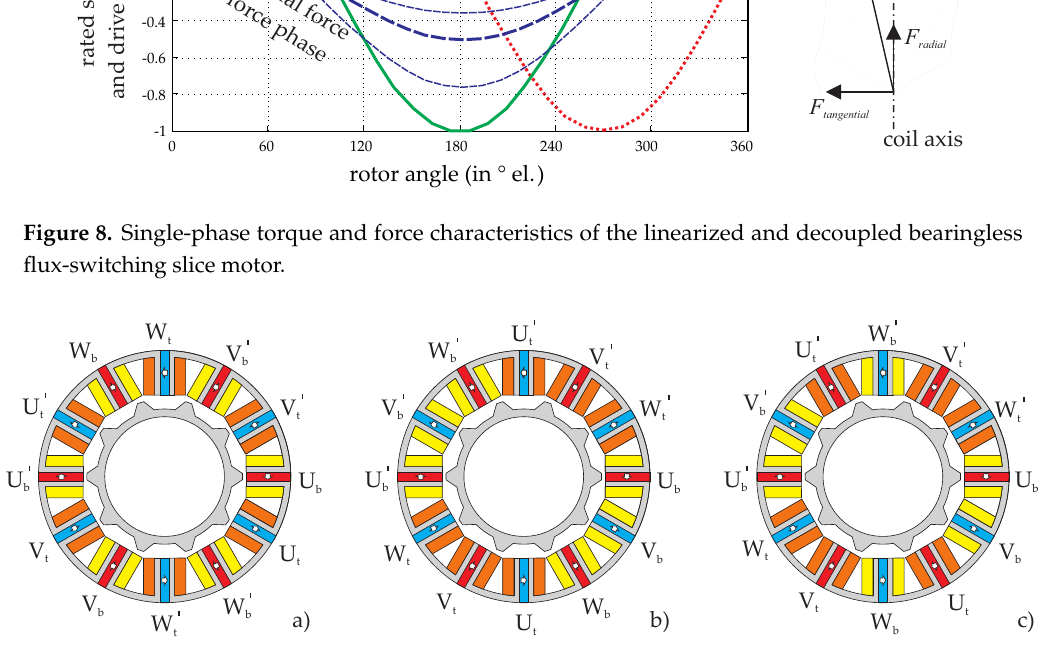
Figure 9. Bearingless flux-switching motor compositions with 12 stator teeth and double three-phase winding